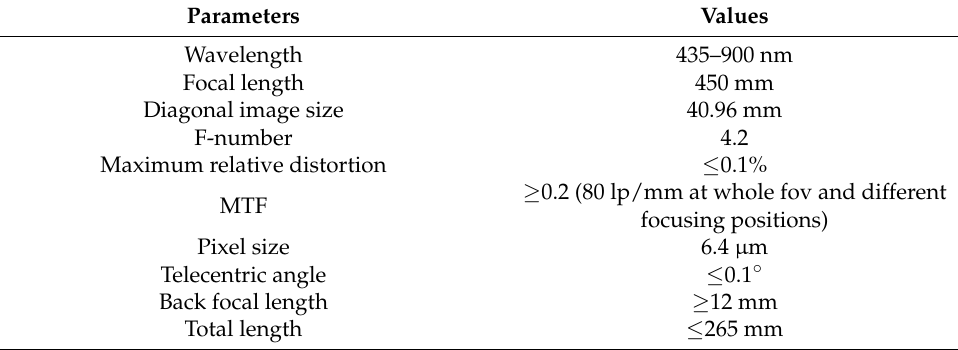
Table 5. Parameters for the optical system of the airborne-mapping camera.